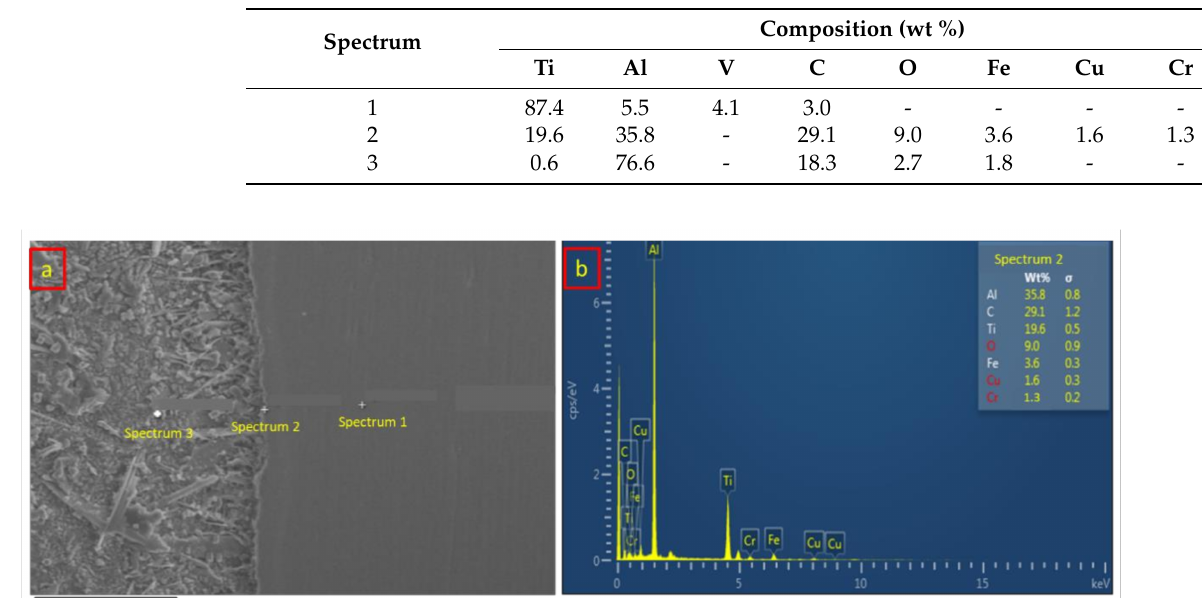
Figure 13. ( a ) Ti/Al spectrum distribution of EDX analysis from sample 3; ( b ) Ti/Al EDX analysis result on the IMC layer from sample